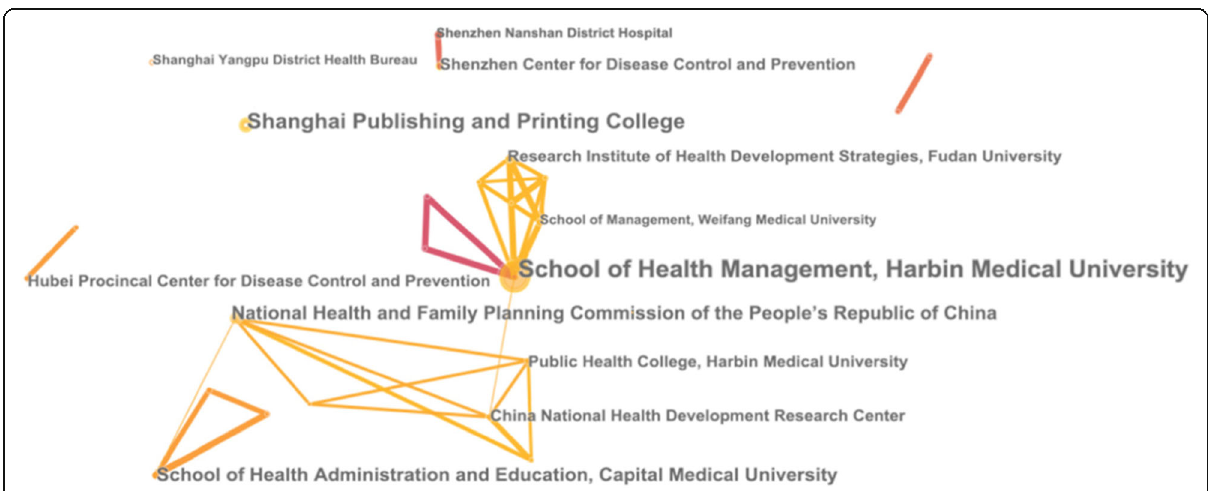
Fig. 6 Co-institution network of Chinese database. Different colors represent different time slices. The colors of rings of a circle are corresponding to the year. The diameter of each circle represents the number of the institution ’ s articles. The link strength between two nodes means the intensity of institution